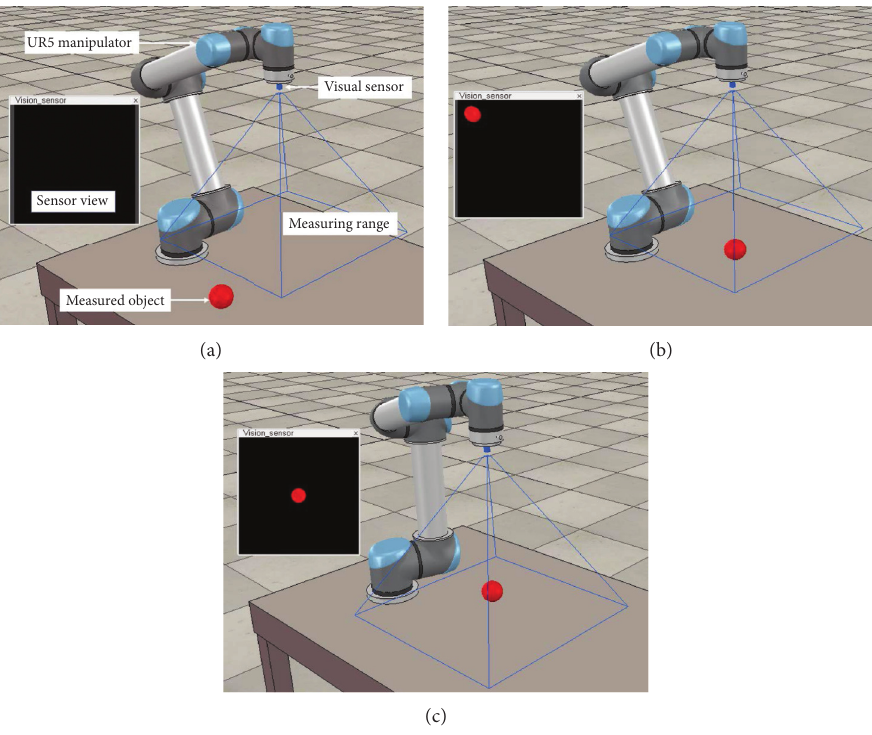
Figure 5: V-rep experiment results on the UR5 manipulator driven by the quadratic programming scheme (11)–(14) aided with GRNN (26) for the visual servoing task. (a) UR5 manipulator installed with a visual sensor. (b) Initial state of the robot visual system. (c) Final state of the robot visual system.